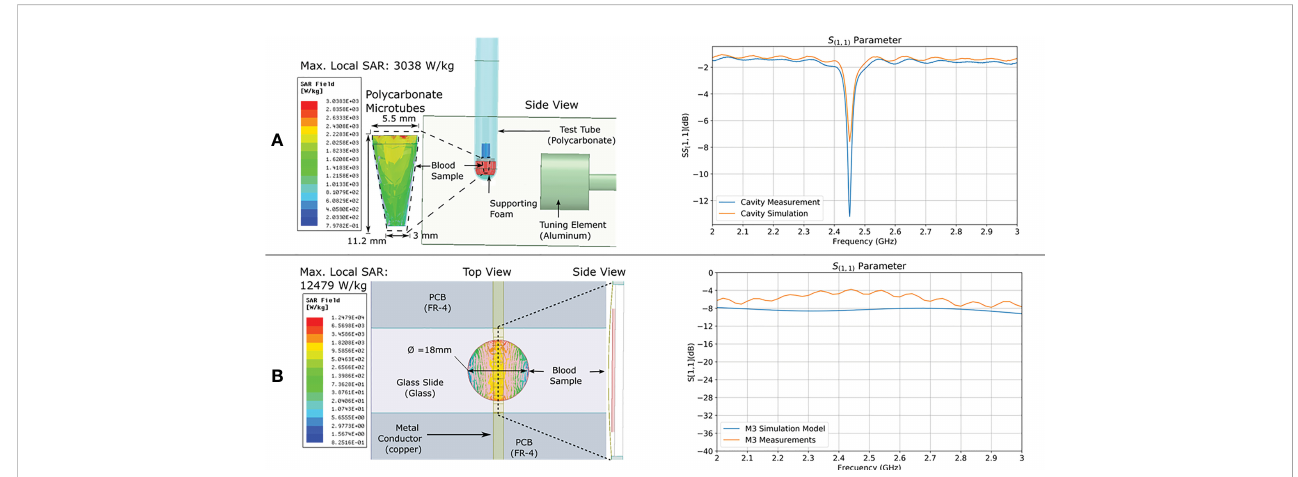
FIGURE 2 FEM SAR modeling and validation. Electromagnetic model of (A) WG and (B) M3; applicators showing calculated maximum local SAR intensity distribution in the sample. To the right of each model are the measured and simulated relative re fl ected power over frequency (scattering parameter S11).